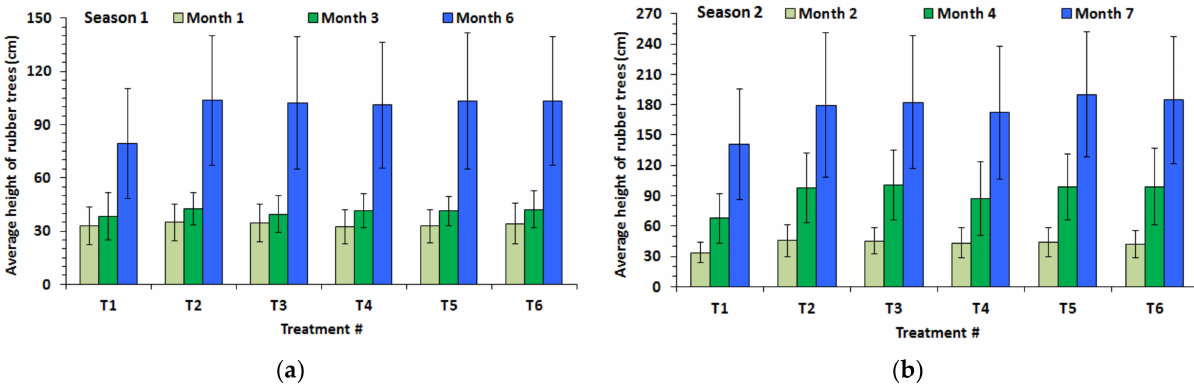
Figure 7. ( a ) Effects of SWA on average height of rubber trees from the experiment performed during season 1 after 1, 3, and 6 months, without watering; ( b ) Effects of SWA on average height of rubber trees from the experiment performed during season 2 after 2, 4 and 7 months, without